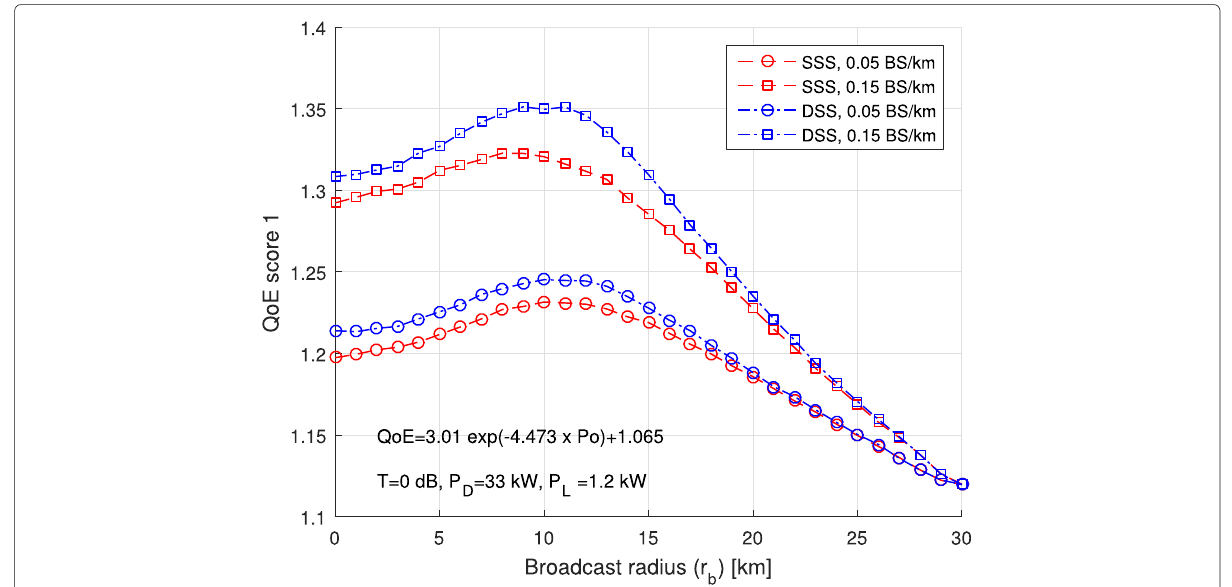
Fig. 14 A comparison between the two scenarios based on the QoE score 1